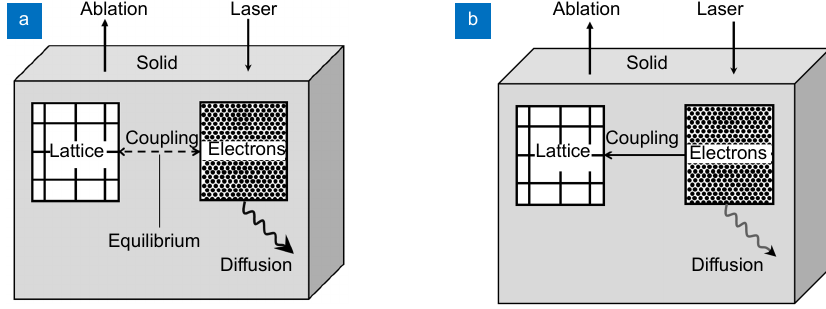
Fig. 1 | Mechanism of laser direct machining transparent brittle materials with long-pulse and ultrashort pulse. ( a ) Schematic diagram of long-pulse laser action. ( b ) Schematic diagram of ultrashort pulse laser. Figure reprinted with permission from ref. 16 ,